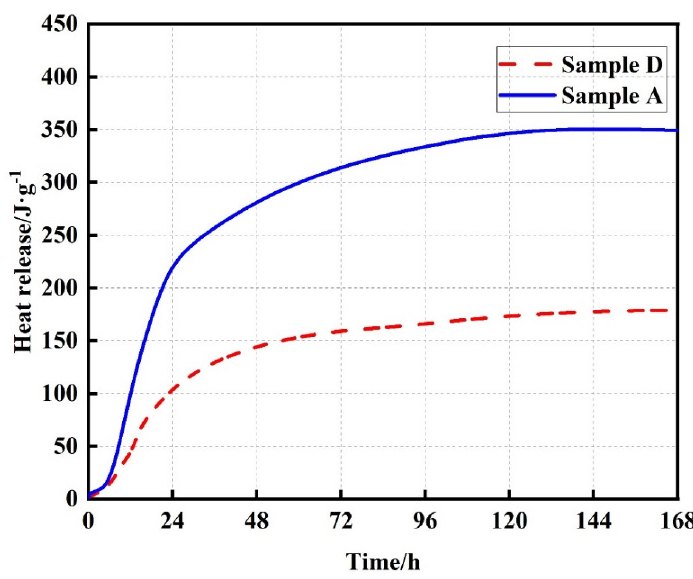
Figure 3. Hydration heat curves for specimen A and specimen D. Table 5. Physical properties of FLS.